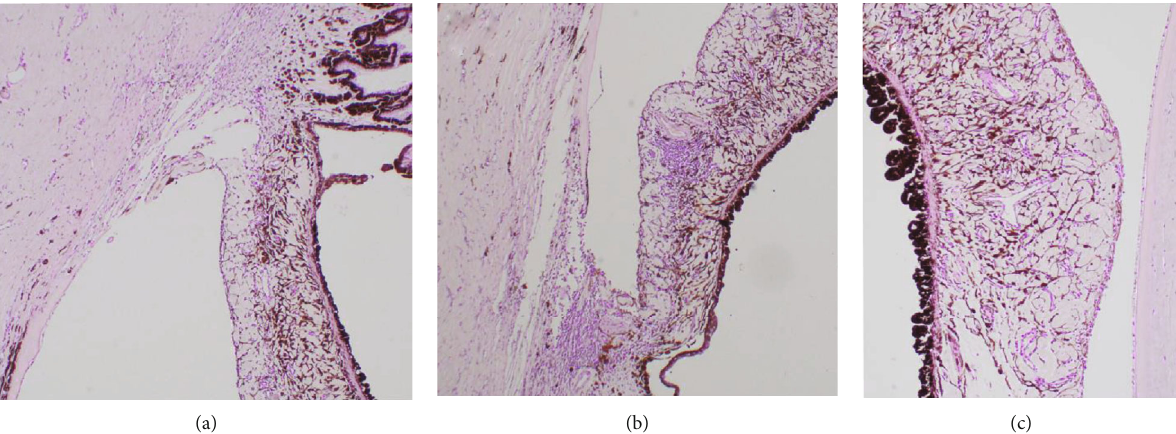
Figure 3: Histopathology images of the enucleated canine globe (OS) with hematoxylin and eosin (H&E) stain. (a) Image of the nondependent ICA demonstrating an open angle and lack of goniodysgenesis at 4x magni fi cation, thus ruling out primary glaucoma as the cause of this patient ’ s glaucoma. (b) Image of the dependent ICA demonstrating an open angle, lack of goniodysgeneis, moderate lymphoplasmacytic in fi ltrate in the iris, ciliary body, and trabecular meshwork, and mild preiridal fi brovascular membrane (PIFM) formation, viewed at 4x magni fi cation. This very mild degree of in fl ammation is incongruent with an 8 month history of uveitis-driven glaucoma, thus supporting a di ff erential cause for this patient ’ s glaucoma, such as AHMS. (c) Image of the iris lea fl et with scant lymphoplasmacytic in fi ltration and scant